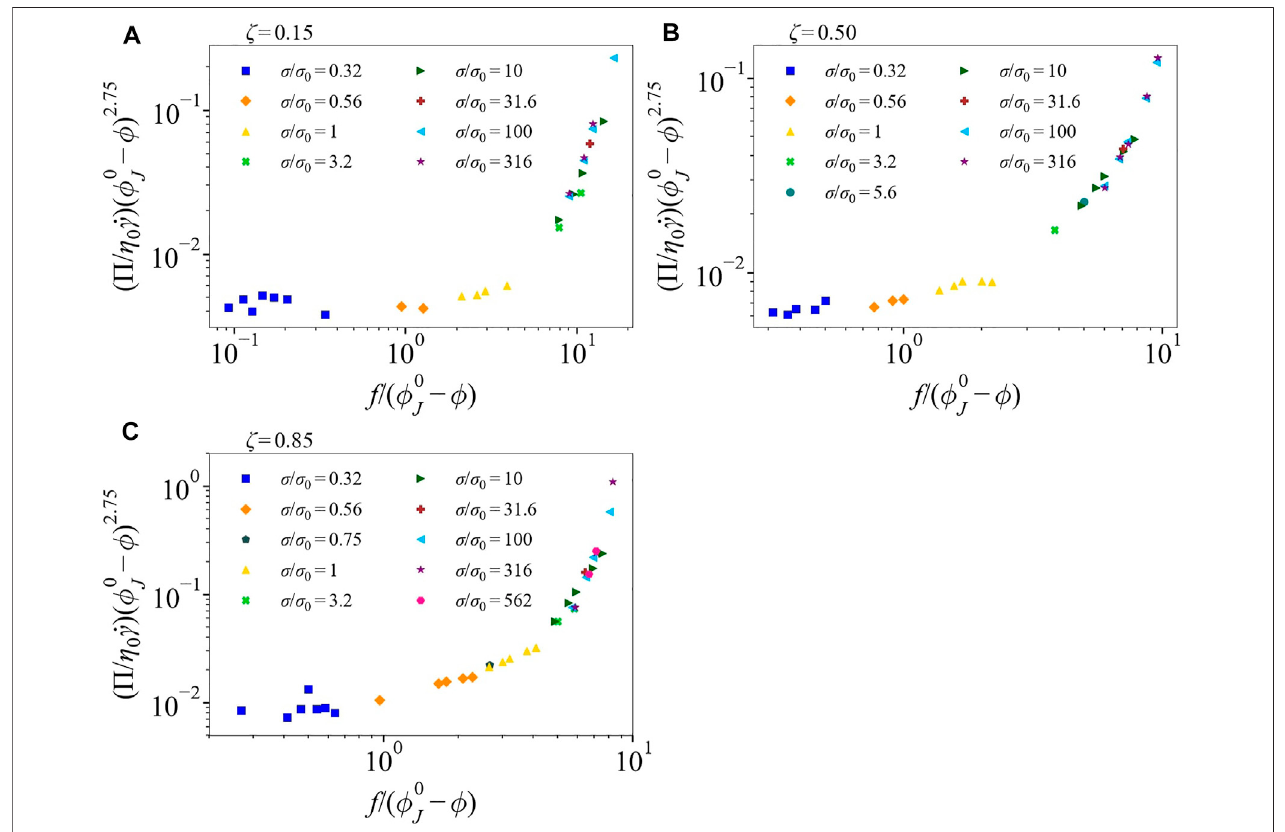
FIGURE 6 | The scaling function F Π (cid:1) ^ Π ( ϕ 0 J − ϕ ) 2 . 75 (note the different exponent relative to F η and F N variable x = f /( ϕ 0 − ϕ )forbidispersesuspensionsat δ =3andvaryinglargeparticlefraction (A) ζ =0.15 (B) ζ =0.50, (C) ζ =0.85over0.54 ≤ ϕ ≤ 0.60and0.32 ≤ σ / σ 0 ≤ 562. For ζ = 0.15, the form of f is exponential f ( σ ) = exp ( σ */ σ ) with σ * = 1.45; for ζ = 0.50 and 0.85, it is fi tted manually f = f fi t .